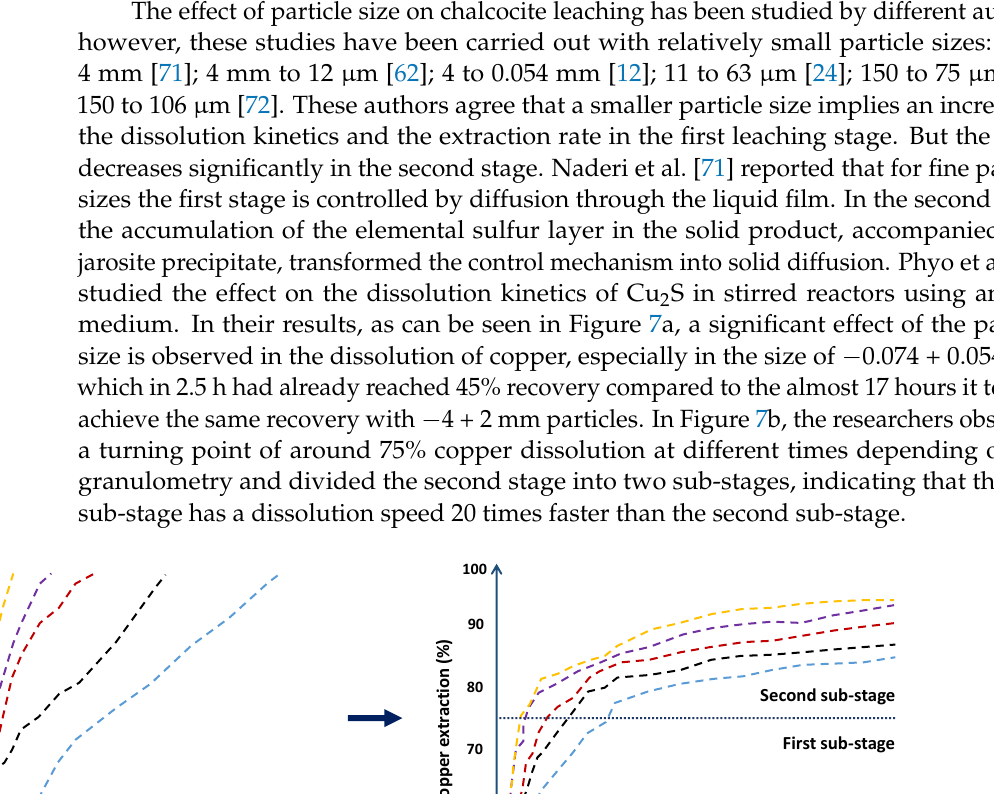
Figure 6. Effect on the H 2 SO 4 concentration in the Cu 2 S solution with the use of wastewater (~40 g/L